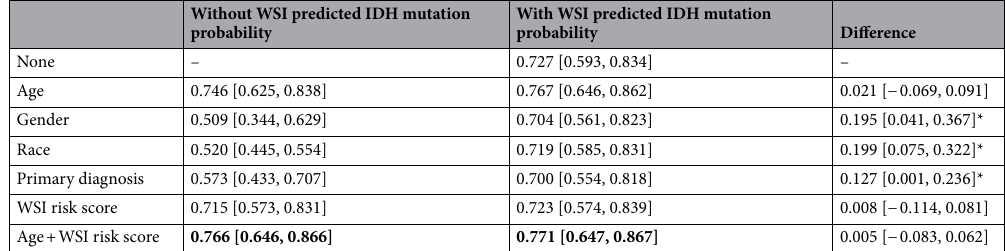
Table 2. Performance of survival prediction using predicted IDH mutation probability evaluated among patients with grade 2 gliomas. 95% confidence intervals were derived from 10,000 bootstrapping replications. Bold texts indicate the best performance for each column. * Indicates statistically significant difference ( p <